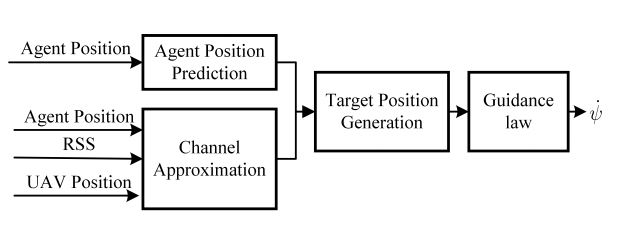
Figure 2. Mobility control